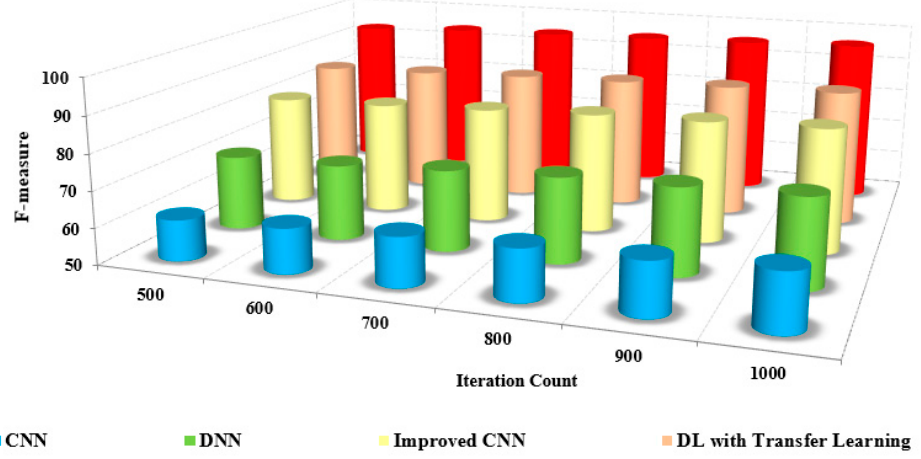
Figure 13. Large iteration count vs. F-score.